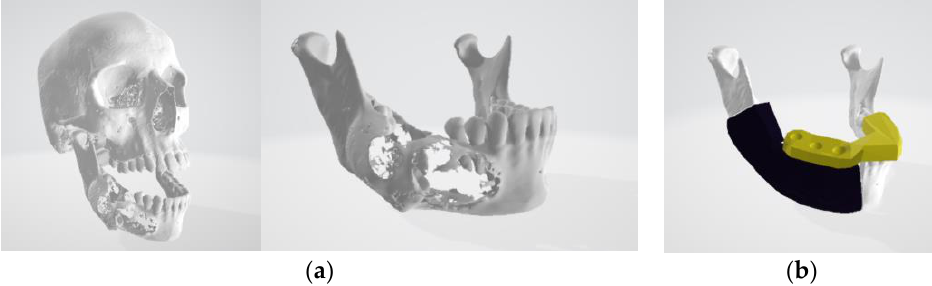
Figure 8. Tumor of the jaw and preoperative 3D strategy planning. ( a ) 3D model of the jaw with bone loss due to the tumor ( b ) 3D model of the jaw with implants. The implants were marked in black and yellow. This view is displayed in front of the users wearing the Microsoft HoloLens 2.